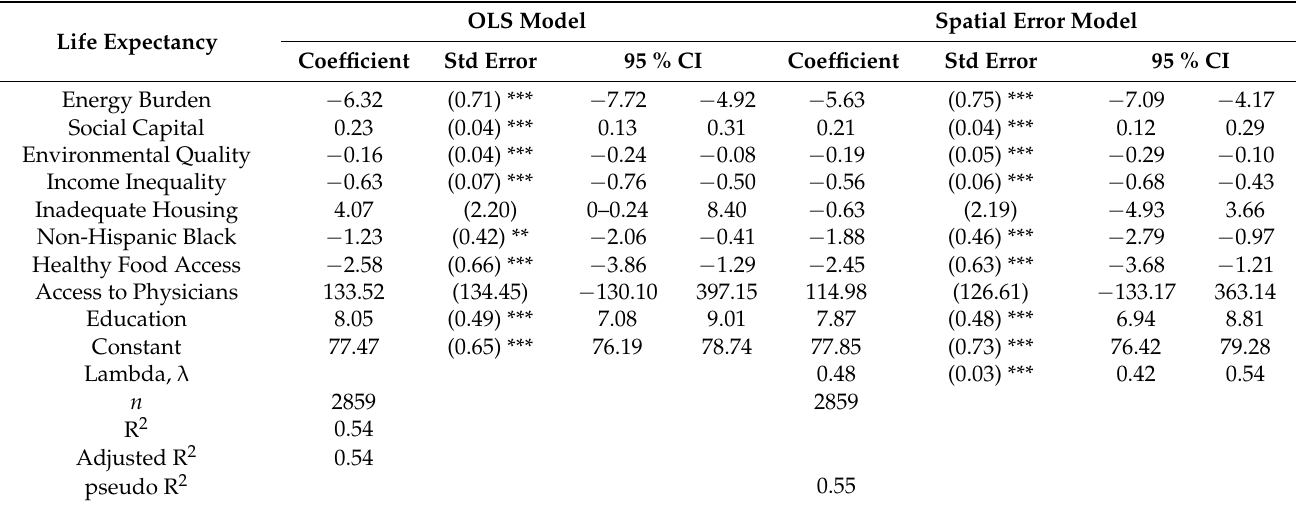
Table 4. The results of spatial error models of factors shaping life expectancy in US